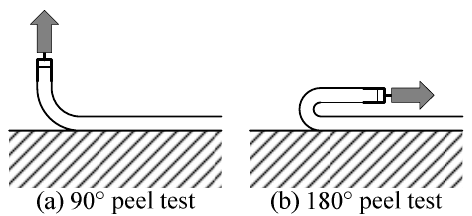
Fig. 5 Schematic views of the 90° and 180° peel test (JIS K 6854).